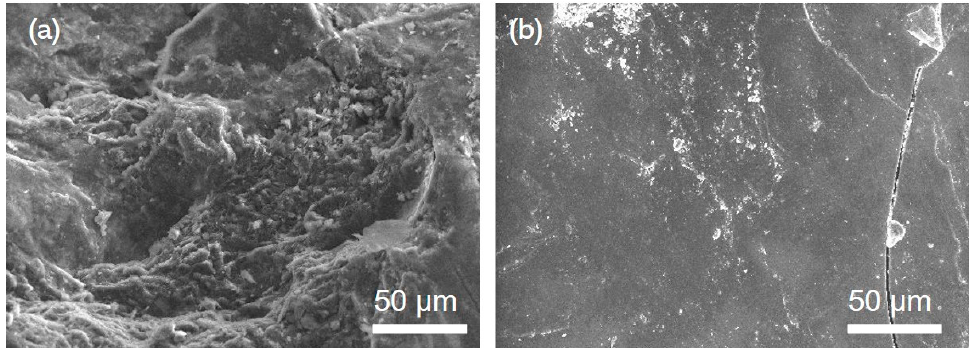
Figure 1. SEM observations for ( a ) tectonic coal and ( b ) non-tectonic coal.